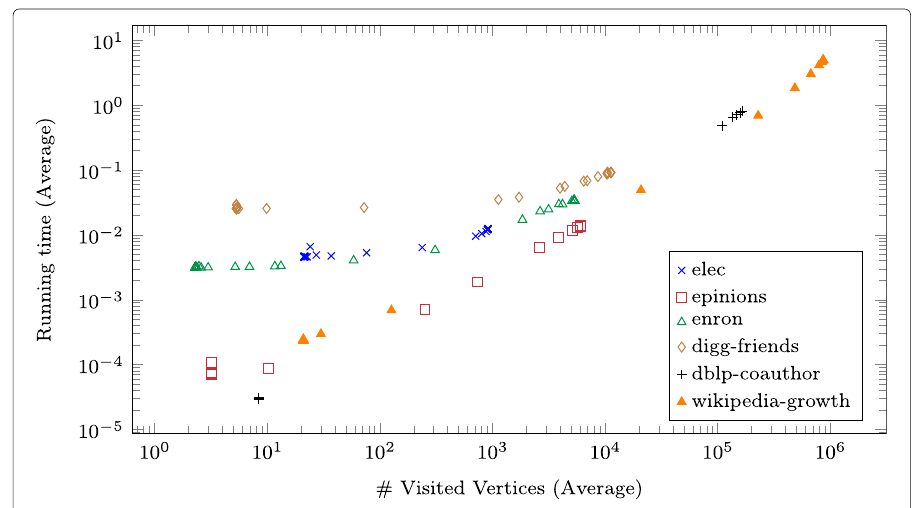
Fig. 6 Average number of visited vertices and its influence on the average running time for foremost . Each data point represents 100 runs of our algorithm for foremost for one of the considered graphs for a specific β -value. The x-coordinate represents the average number of visited vertices and the y-coordinate indicates the average running time